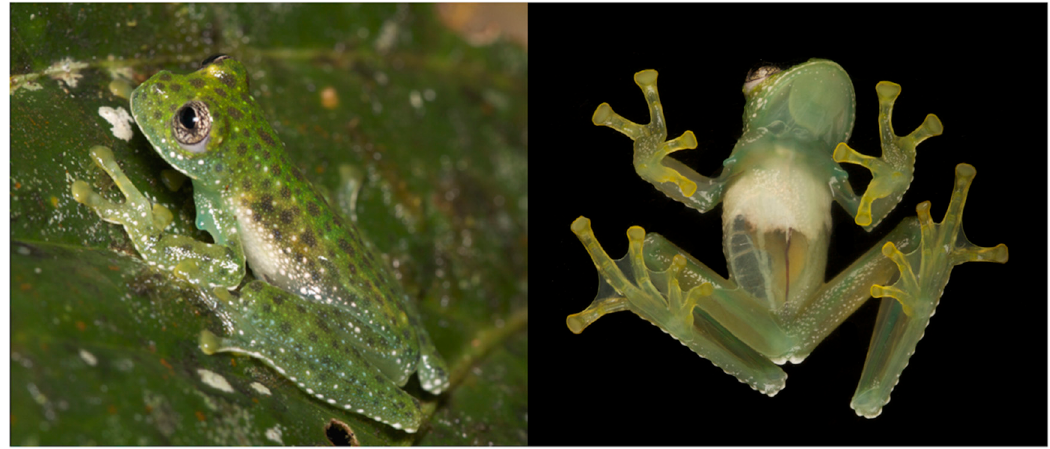
Figure 41. Centrolene huilensis in life. Ecuador, Napo province, Yanayacu Biological Station, QCAZ 45905. Photos by Santiago R. Ron (BioWebEcuador).